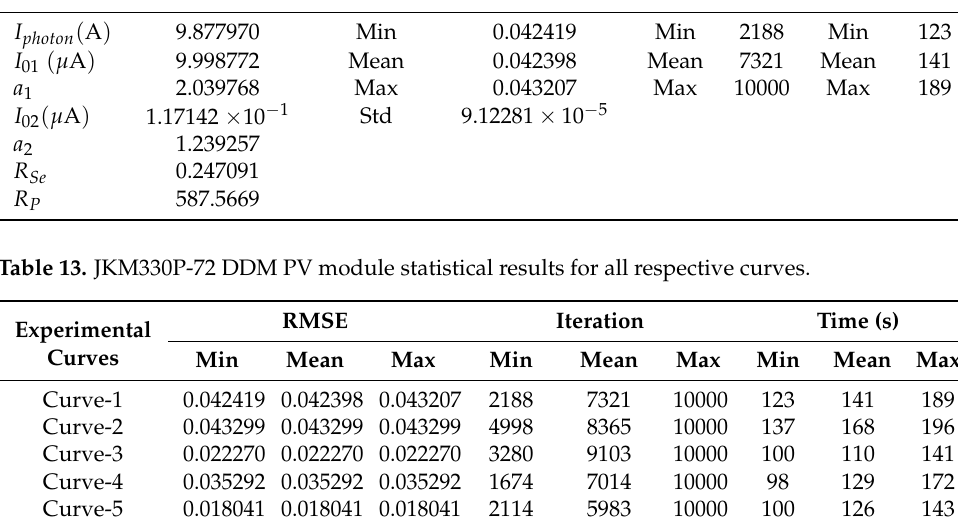
Table 12. Obtained statistical results for DDM JKM330P-72 PV module for curve 1. Obtained Optimal